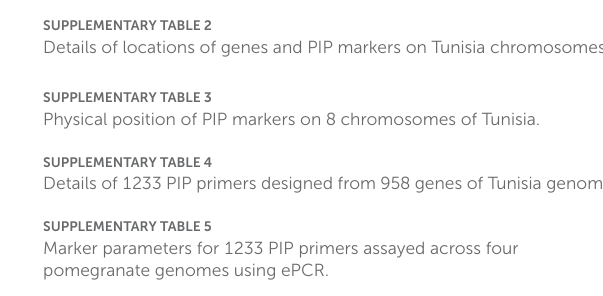
SUPPLEMENTARYTABLE3 Physical position of PIP markers on 8 chromosomes of Tunisia. SUPPLEMENTARYTABLE4 Details of 1233 PIP primers designed from 958 genes of Tunisia